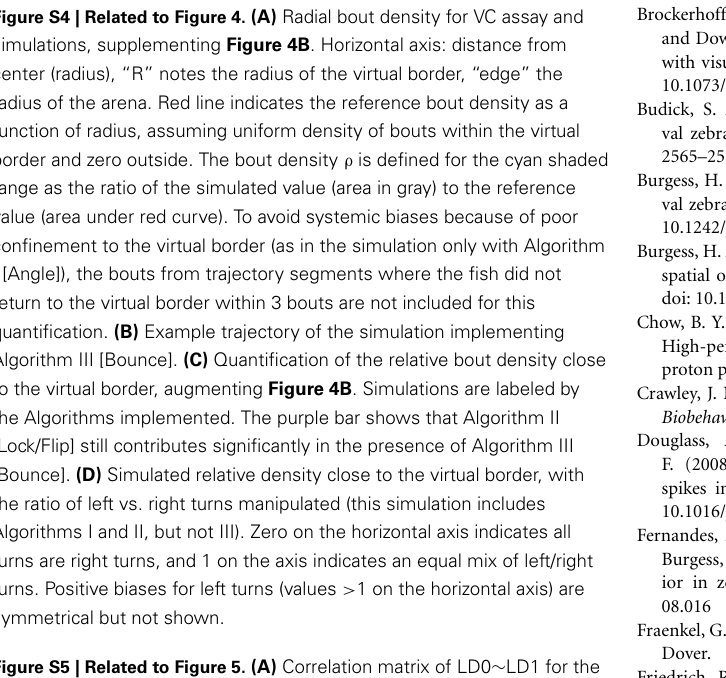
incorporating Algorithm II. (C) Compare to Figure 3N , color-coded as in (B) . Figure S4 | Related to Figure 4. (A) Radial bout density for VC assay and simulations, supplementing Figure 4B . Horizontal axis: distance from center (radius), “R” notes the radius of the virtual border, “edge” the radius of the arena. Red line indicates the reference bout density as a function of radius, assuming uniform density of bouts within the virtual border and zero outside. The bout density ρ is defined for the cyan shaded range as the ratio of the simulated value (area in gray) to the reference value (area under red curve). To avoid systemic biases because of poor confinement to the virtual border (as in the simulation only with Algorithm I [Angle]), the bouts from trajectory segments where the fish did not return to the virtual border within 3 bouts are not included for this quantification. (B) Example trajectory of the simulation implementing